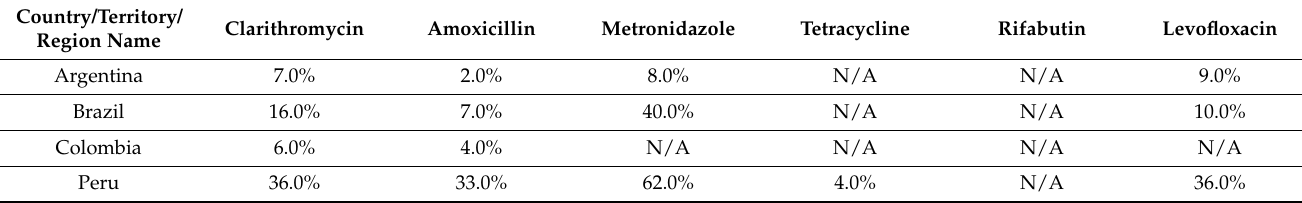
Table 3. South America Regional Rates of Resistance.